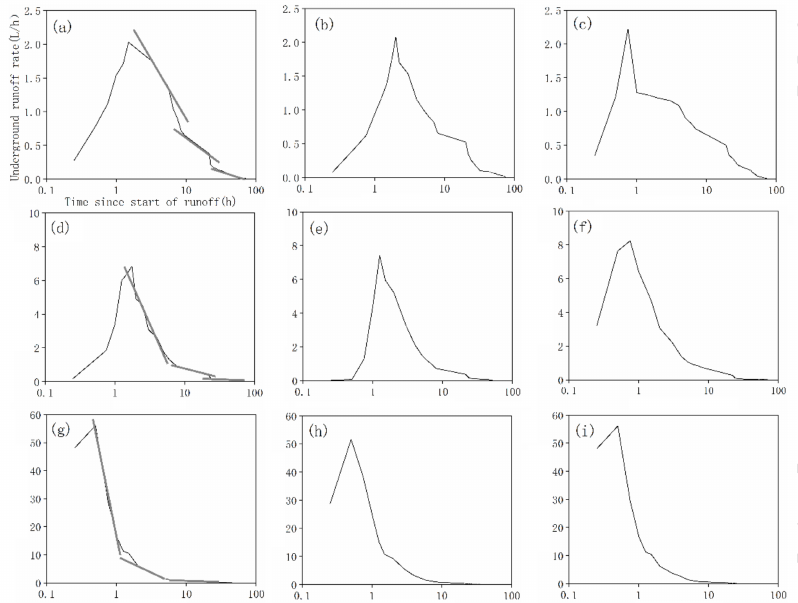
Figure 2. Dynamics of underground runo ff for light rocky desertification (LRD) ( a , d , g ), moderate rocky desertification (MRD) ( b , e , h ) and severe rocky desertification (SRD) ( c , f , i ) under 30 mm / h ( a – c ), 60 mm / h ( d – f ) and 90 mm / h ( g – i